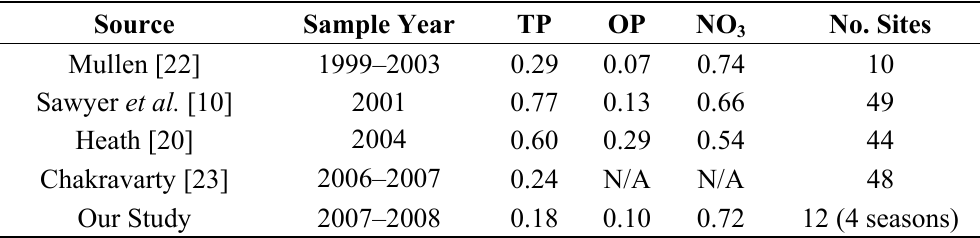
Table 5. Historical means of total phosphorus (TP), orthophosphate (OP), and nitrate (NO ) in studies on the Choctawhatchee River watershed. Note: Our study in one watershed 3 (LCR), others within multiple watersheds within the Choctawhatchee River